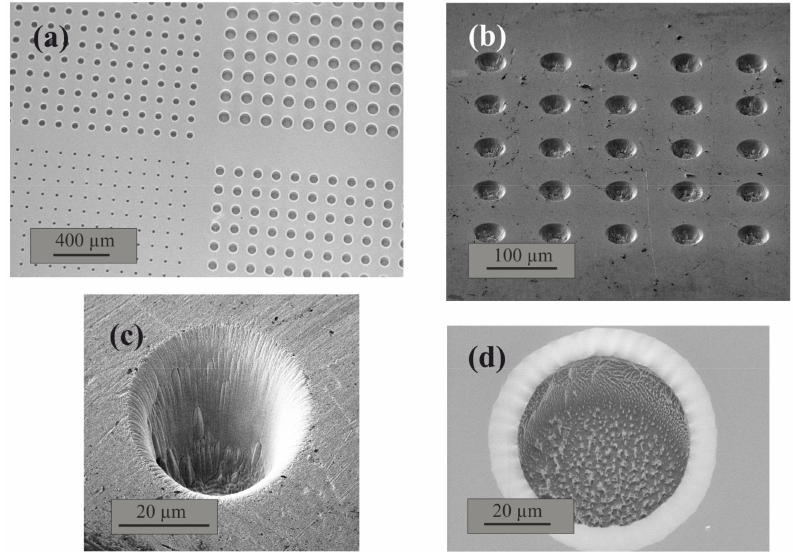
Figure 1. Different electron micrographs of the freezing chip. ( a ) Cavities of different size (ca. 20 to 80 µ m) arranged on the freezing chip; ( b ) A more detailed picture of the arrangement of the ca. 40 µ m cavities; ( c ) A 40- µ m cavity sputtered in gold by ion milling and ( d ) a 40- µ m cavity etched in the gold plate via Ar-SF6